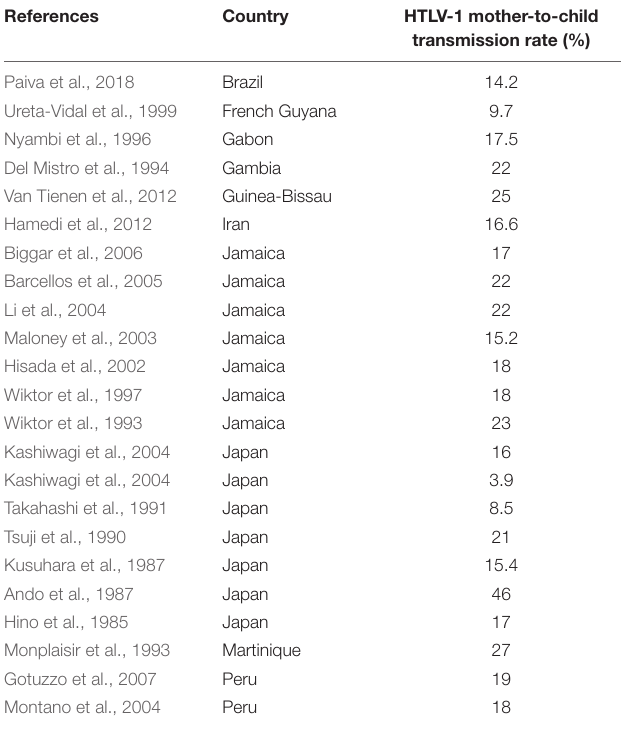
TABLE 1 | Rate of HTLV-1 mother-to-child